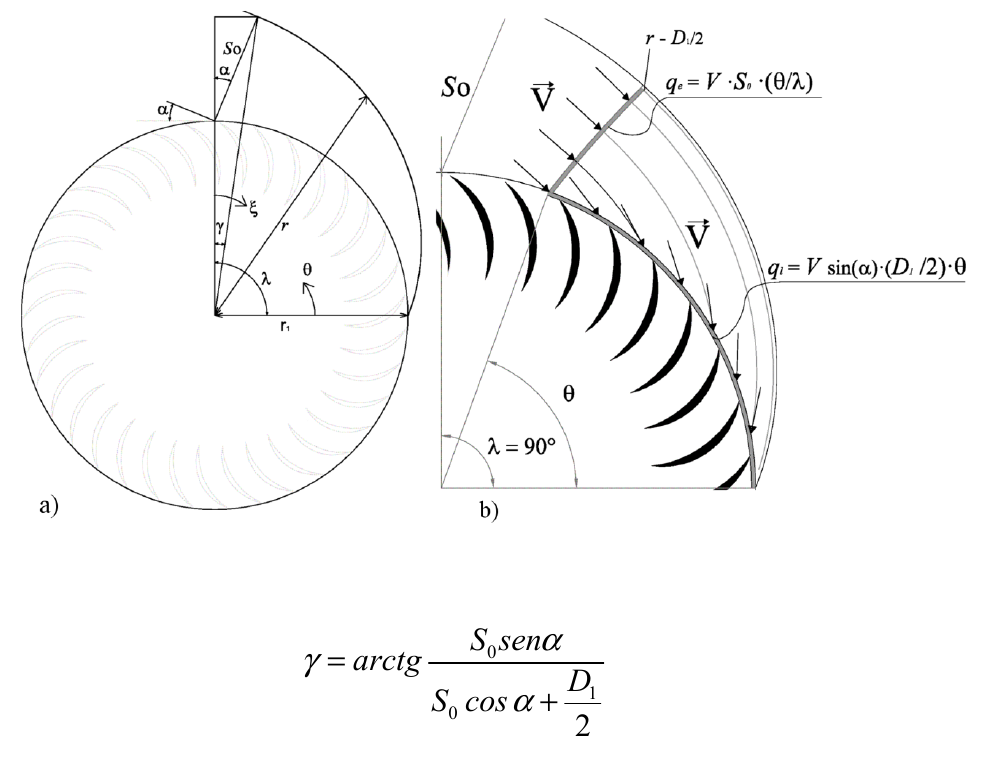
Figure 3. Nozzle upper wall shape: ( a ) geometric scheme; ( b ) entering and leaving water flow in the